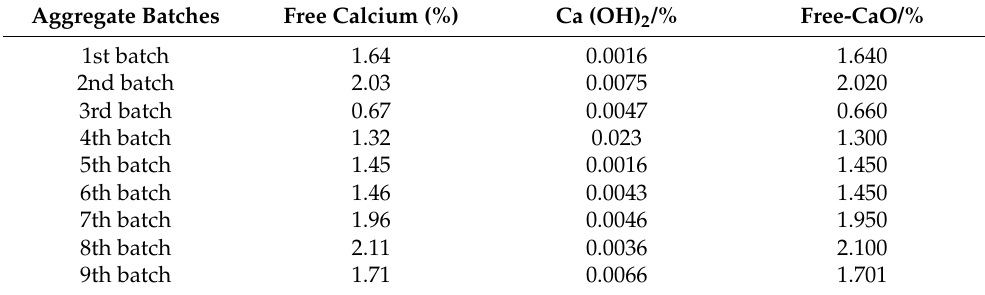
Figure 1. Steel slag alkalization. Table 2. Free CaO content.